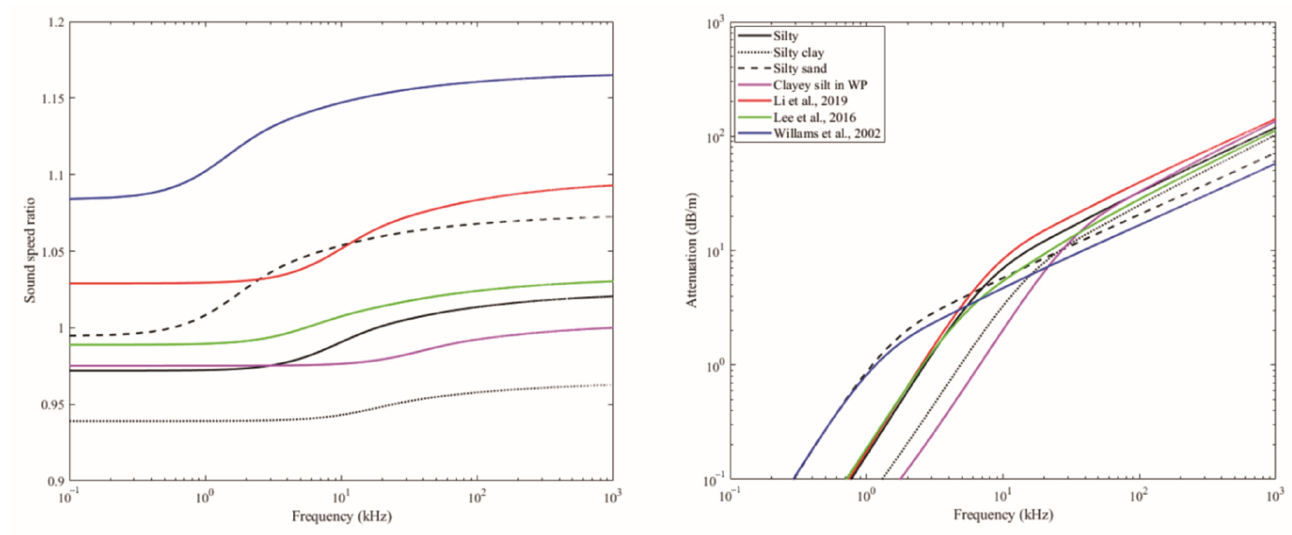
Figure 6. The sound speed and attenuation dispersion for different area and sediment types. The blue line is coarse sand [1], The red line is fine sand [21], the green line is sandy silt [22], and the purple line is clayey silt in WP.